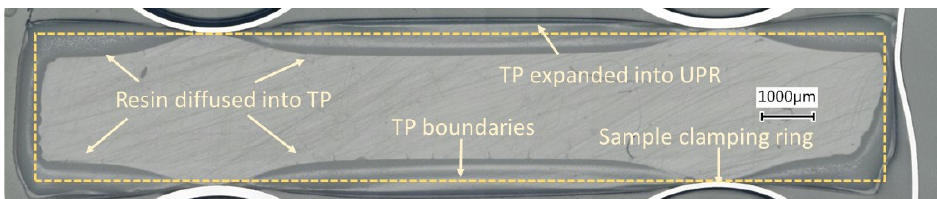
Figure 6. Overall view of the interphase formed between ABS and UPR at 25 °C.